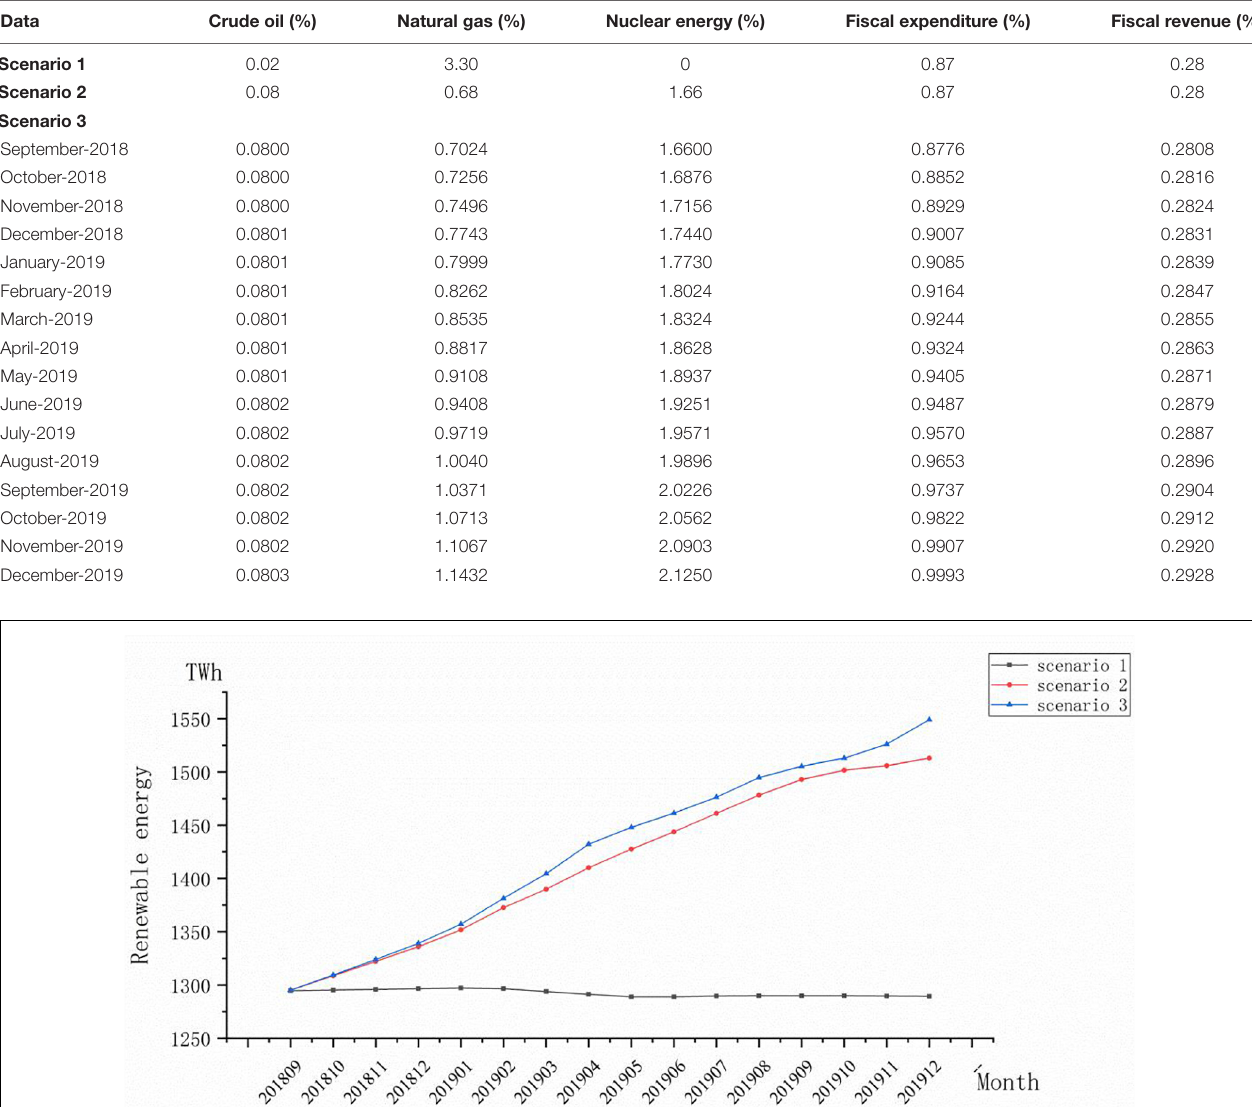
TABLE 2 | The rate of growth in each scenario.